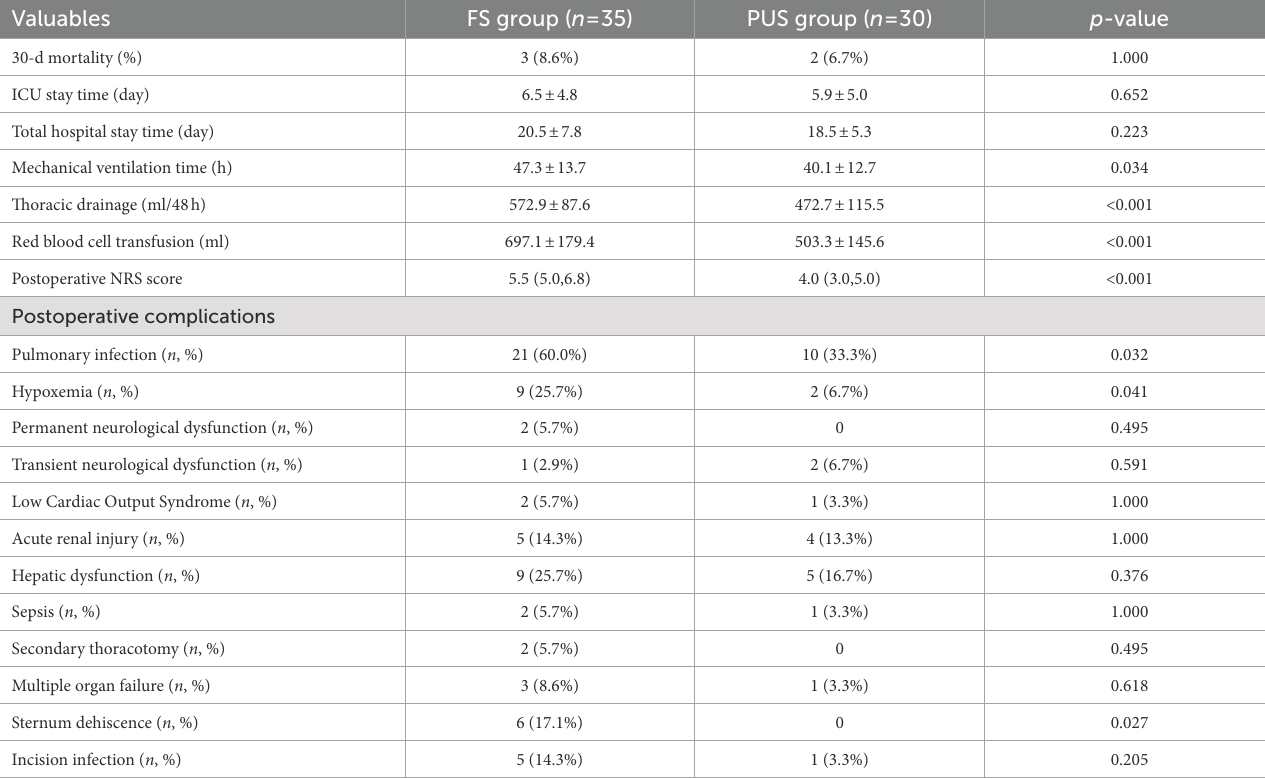
TABLE 3 Comparison of postoperative results between the two groups ( n = 65).